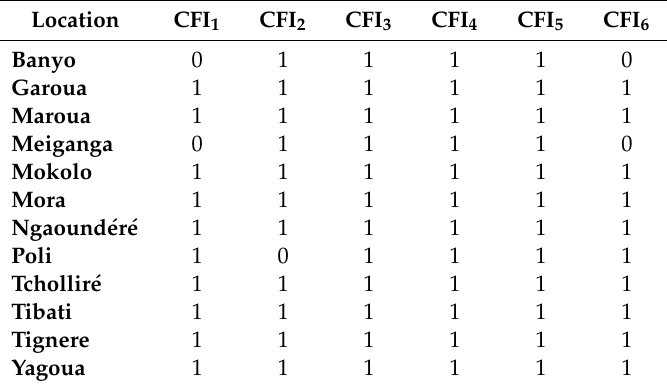
Table 12. The critical factor indices for each